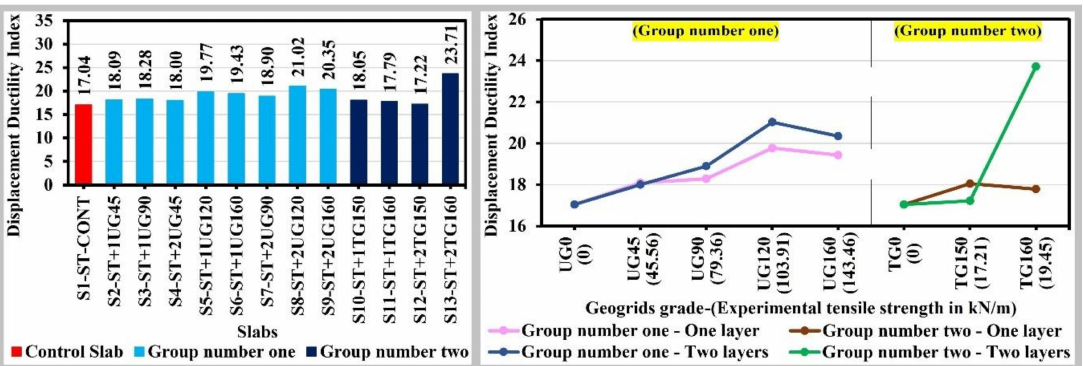
Figure 14. The displacement ductility index values and the relation between the displacement ductility index and the tensile strength of geogrids or the number of geogrids’